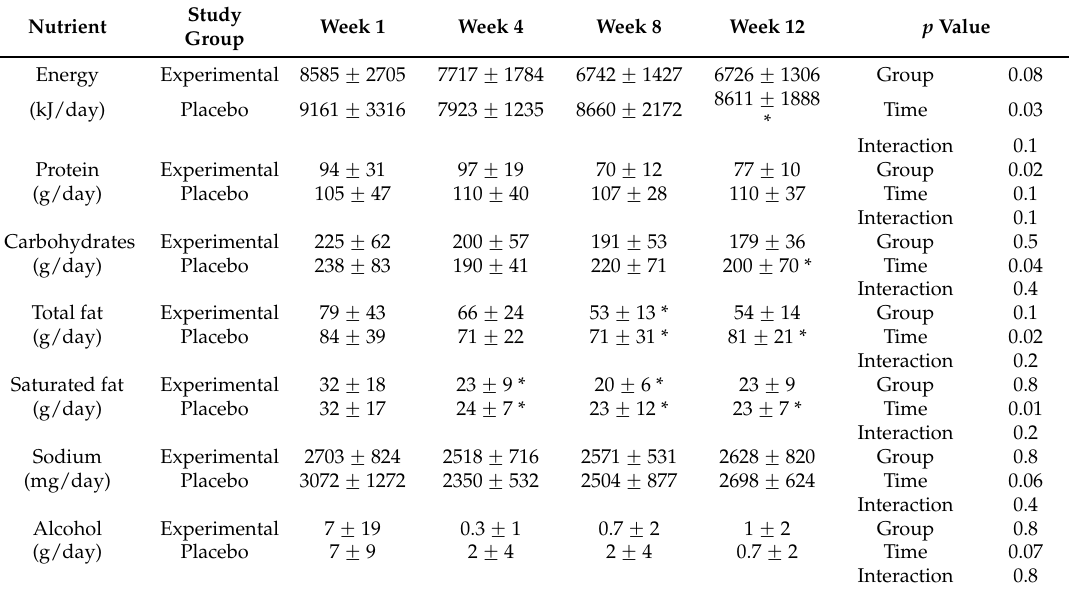
Table 4. Dietary intake of energy and nutrients obtained from participants’ food diary records at week 1, 4, 8 and 12 ( n = 15 in each